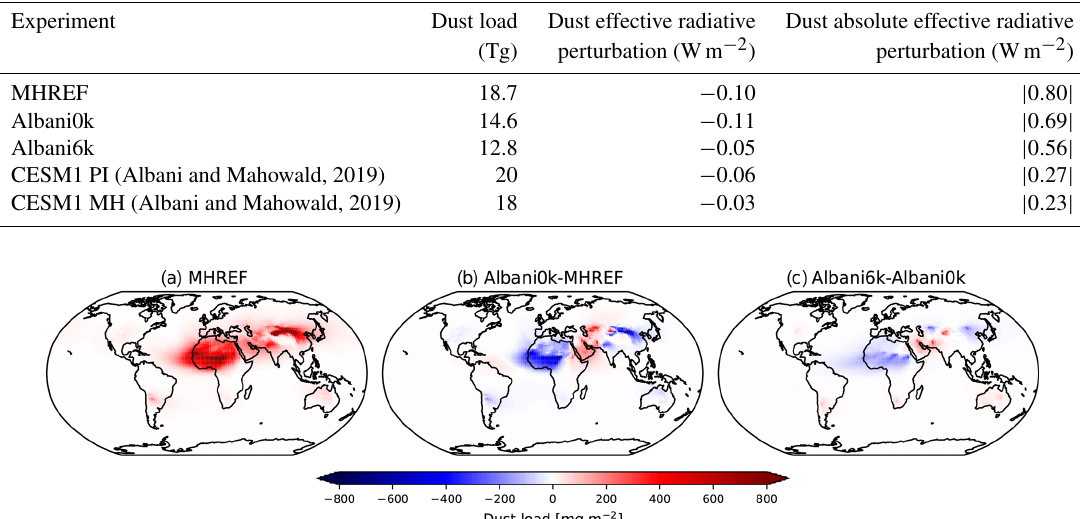
Table 2. Global budgets of simulated dust-related variables. Dust effective radiative perturbation (Wm − 2 ) is the globally averaged net (SW+LW) TOA effective radiative perturbation estimated from the first 50 years of the simulation and calculated as a difference compared to the NODUST simulation. It thus includes initial model adjustment as discussed in Albani and Mahowald (2019). The Dust absolute effective radiative perturbation (Wm − 2 ) is similar but considers the perturbation irrespective of the sign. The CESM1 PI and MH cases refer to the original simulations (Albani and Mahowald, 2019) that serve as the PMIP4 dust reference fields (Otto-Bliesner et al., 2017). This is the only table for which the comparison is done to NODUST, since it highlights the impact of dust in the climate system and not the effect of dust on the mid-Holocene climate, which is discussed in the main text of the paper.